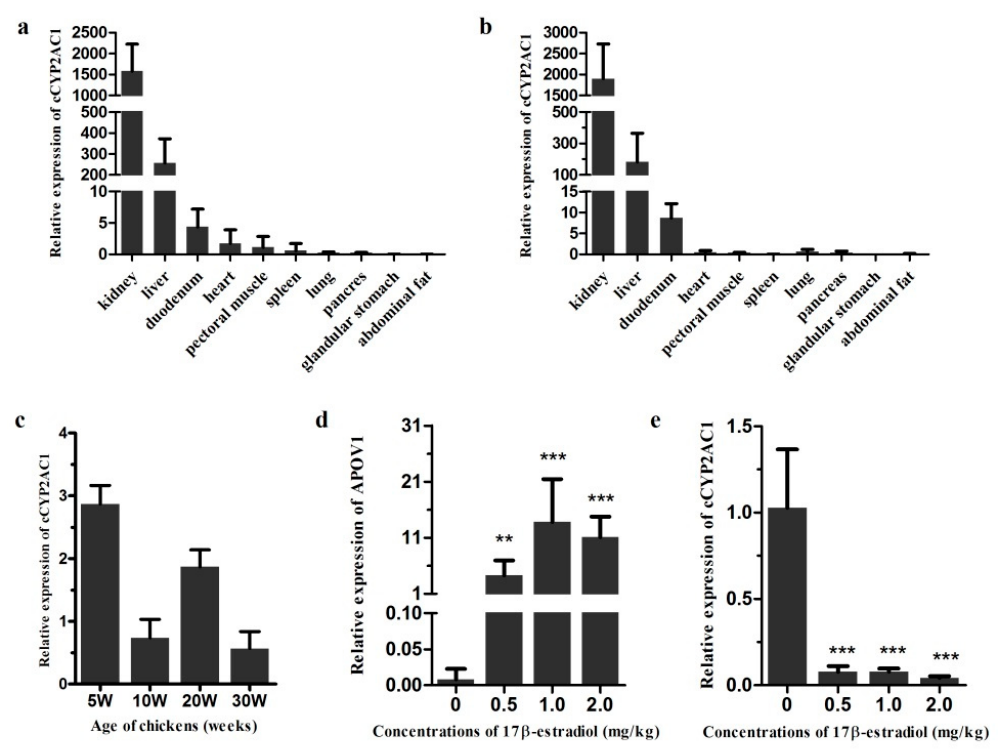
Figure 6. Expression characteristics and regulation of cCYP2AC1. ( a ) Tissue distribution of cCYP2AC1 in 10 week old chicken tissues. ( b ) Tissue distribution of cCYP2AC1 in 30 week old chicken tissues. ( c ) Expression patterns of cCYP2AC1 in livers of chickens at di ff erent developmental stages. ( d ) E ff ect of 17 β -estradiol on APOV1 mRNA expressions in the liver of chickens. ( e ) E ff ect of 17 β -estradiol on cCYP2AC1 mRNA expressions in the liver of chickens. Each data point represents the mean ± SD ( n = 3–6; t -test; ** p < 0.01; *** p < 0.001; NS p >